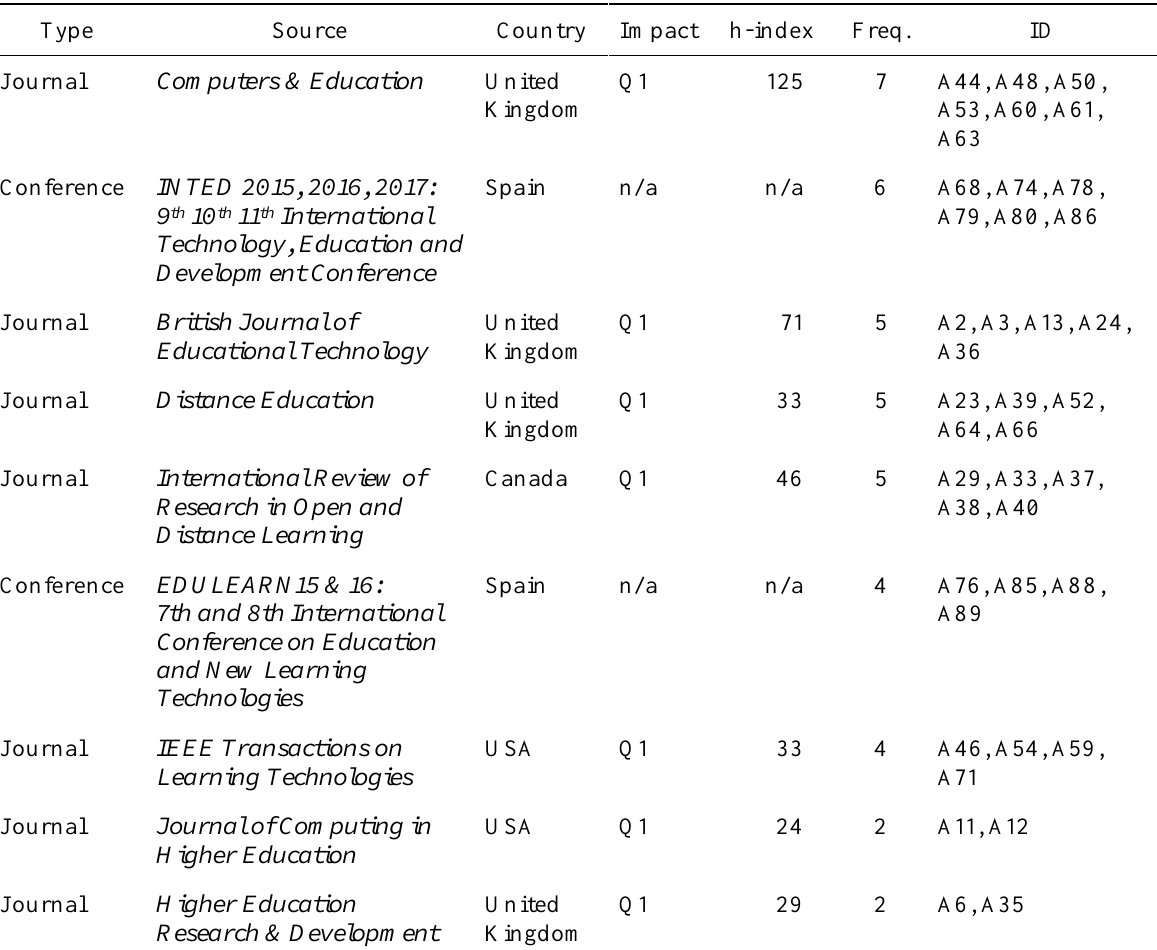
Frequencies by Type of Document and Source